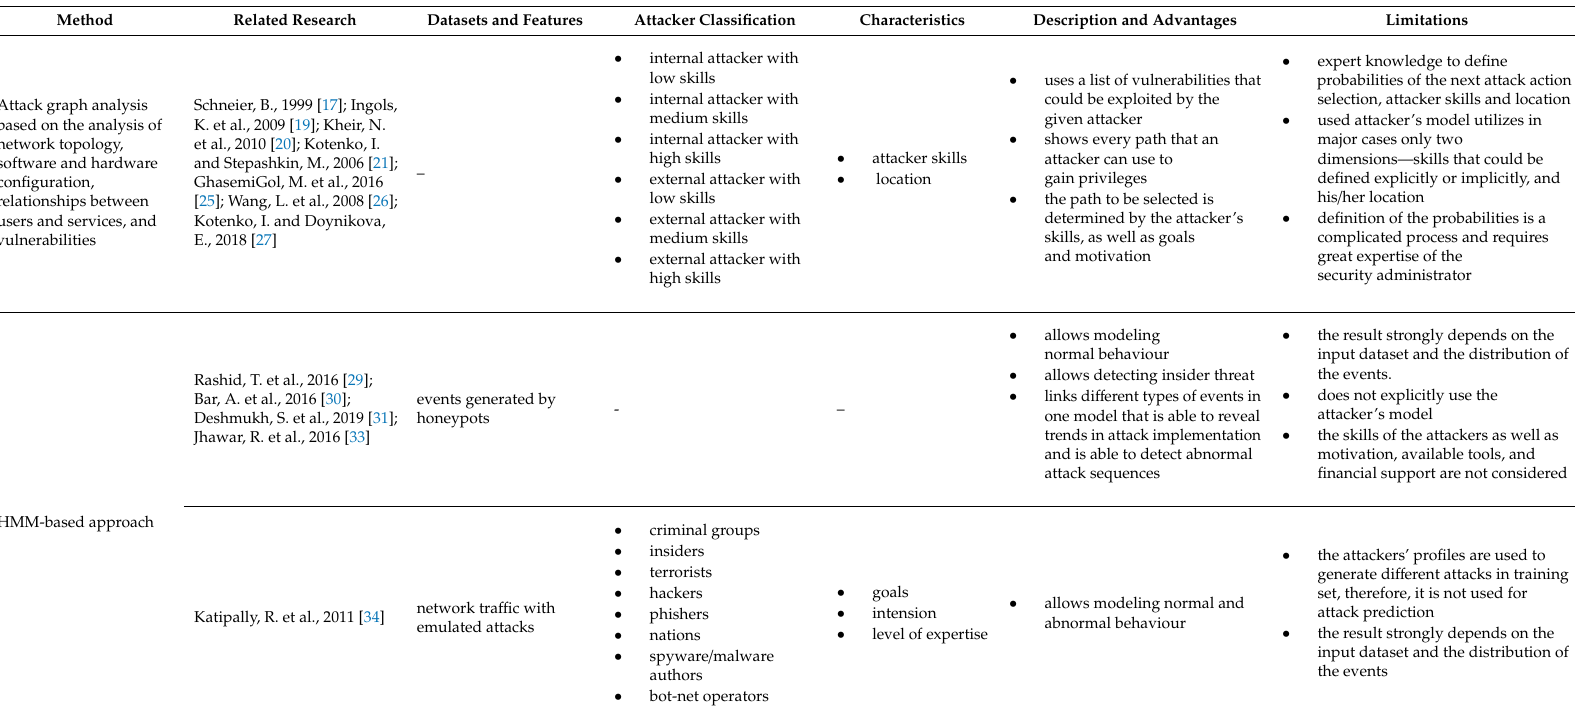
Table 1. Techniques for attacker profile specification and its application for attack forecasting. HMM, hidden Markov model; RNN, recurrent neural network; CPS, cyber-physical